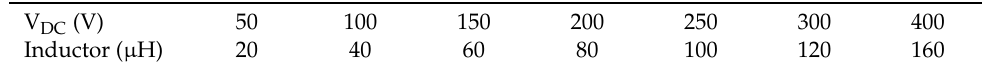
Figure 3. Normalized and measured dynamic on-resistance (R ON ) value at 1.96 µ s after turn on for different voltage stresses by the double pulse test (DPT) method. Table 1. Inductors corresponding to the different off-state